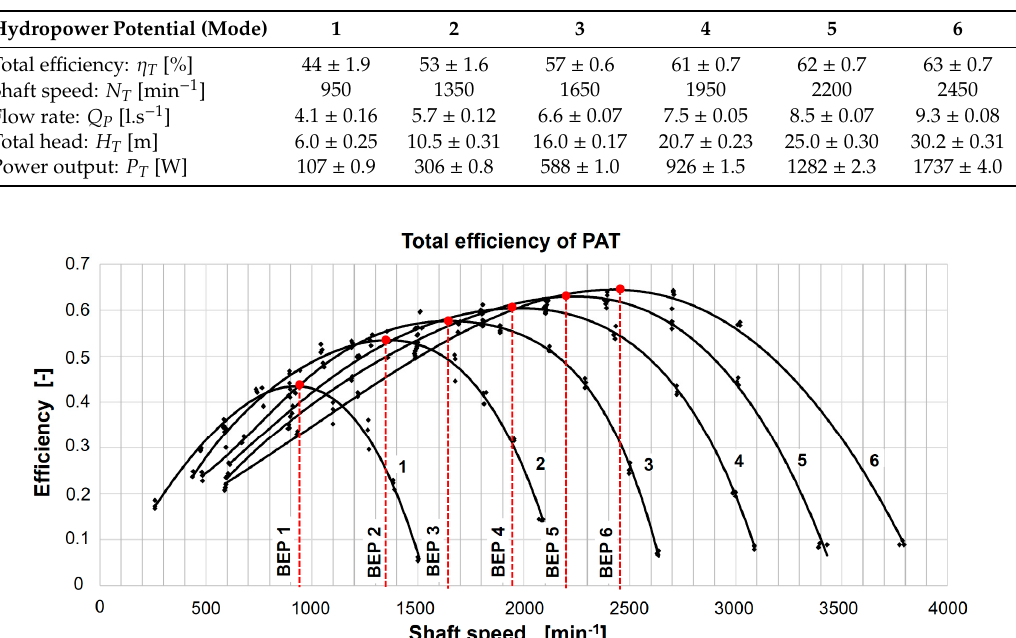
Table 2. Performance parameters of tested PAT at BEP.